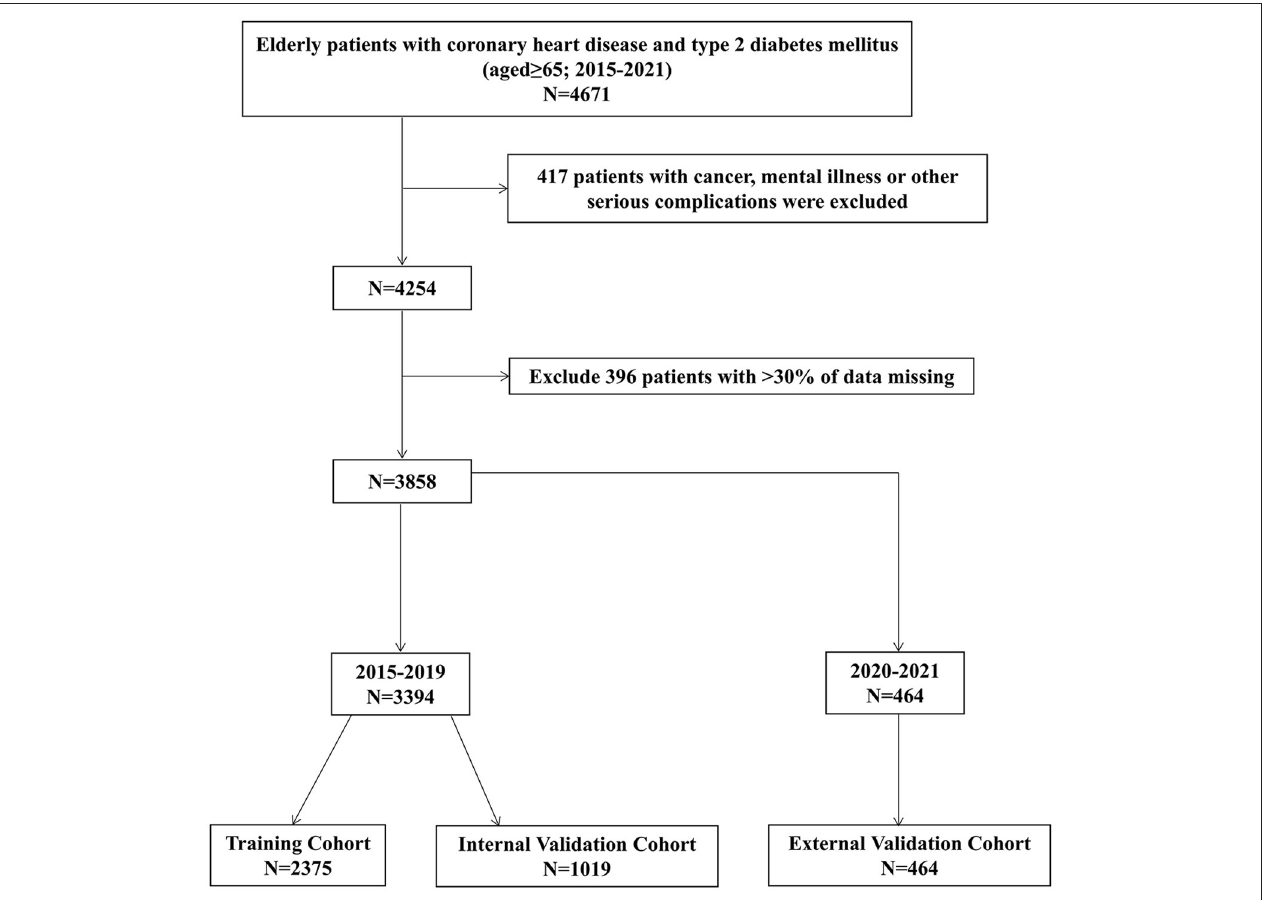
FIGURE 1 | Flow of inclusions and